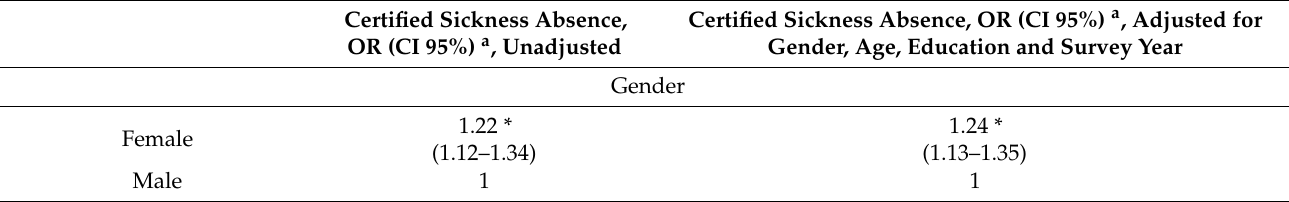
Table 2. The odds of self-reported medically certified sickness absence within the previous year in association with socio-demographic